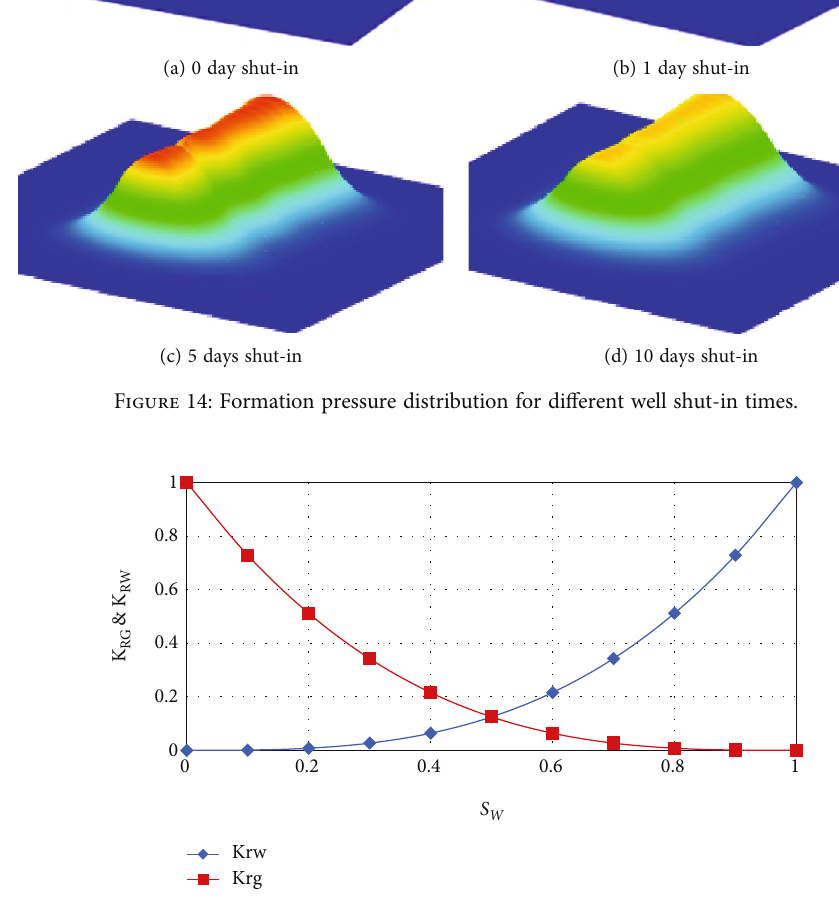
Figure 15: Gas-water two-phase relative permeability